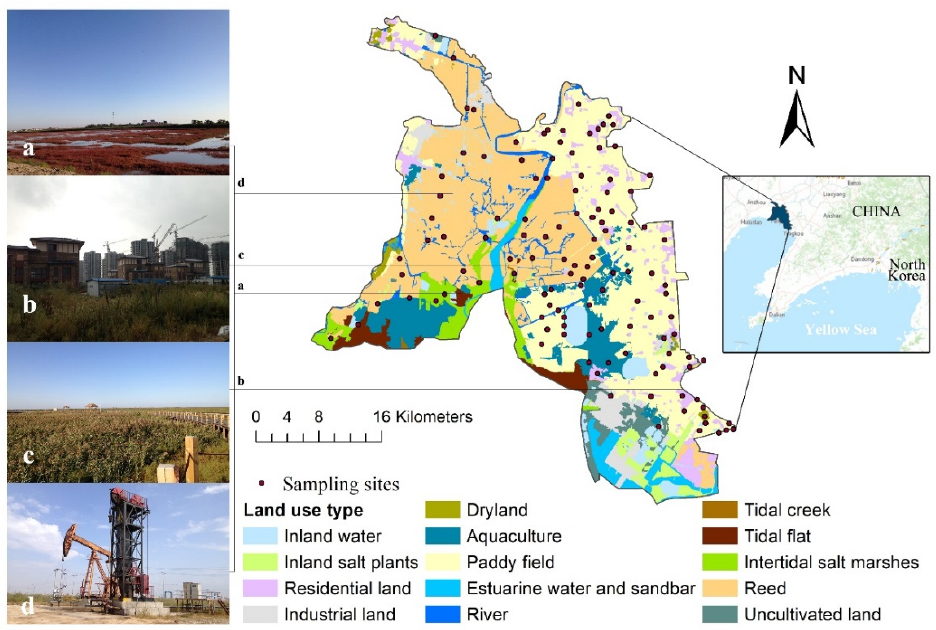
Figure 1. Location of the Liao River Delta: ( a ) destroyed wetlands; ( b ) urban sprawl; ( c ) low-intensity tourism development; ( d ) industrial development.